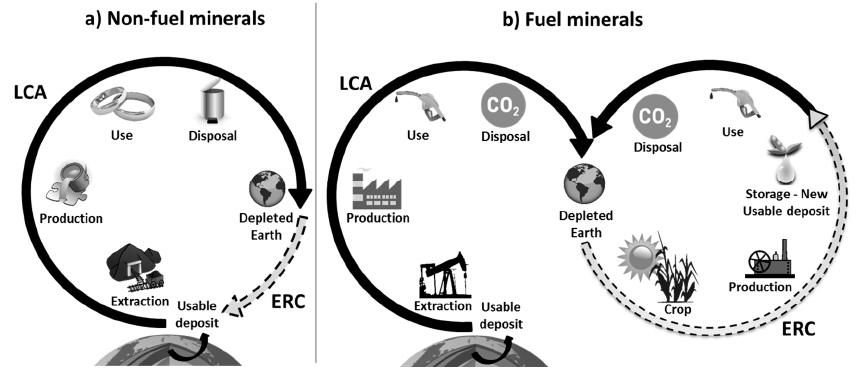
Figure 2. ERC scope of non-fuel minerals (based on the theory presented in [6]) and fossil fuels minerals. Note: Using the non-fuel mineral method for fuels does not permit the closure of the energy and material cycle, and so the ERC cannot be calculated unless the alternative (bio-energy) pathway is employed. Adapted from [8]